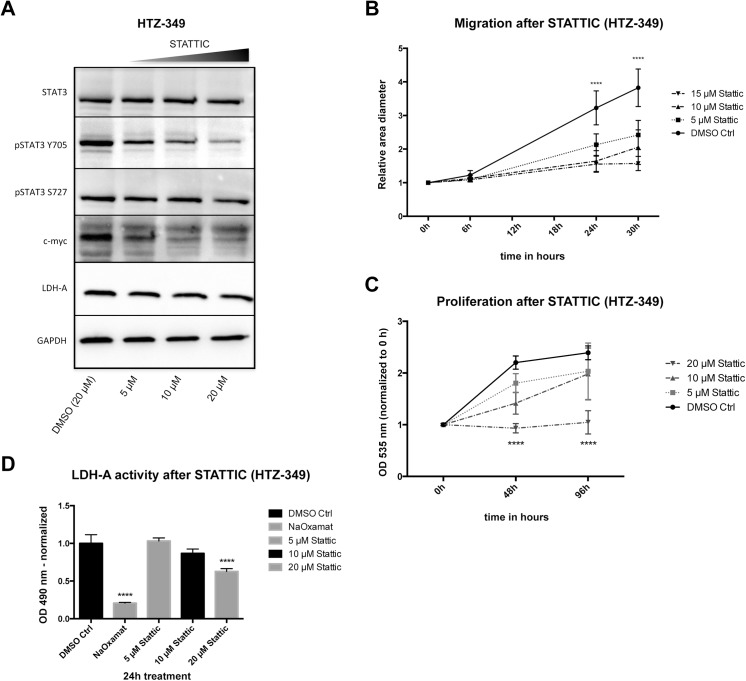
Inhibition of STAT-3 phosphorylation modulates signalling along with functional effects.STAT-3 phosphorylation at Y705 is inhibited by STATTIC. HTZ-349 cells were exposed to increasing STATTIC concentrations (5, 10, 15/20 μM) for 24 h. (A) pSTAT-3, c-myc, and LDH-A expression were investigated by Western blot (40 μg of protein). A decrease in both phosphorylation of pSTAT-3 and expression of its downstream targets, c-myc and LDH-A, was observed. Total STAT-3 and STAT-3 phosphorylated at the S727 residue remained unchanged (for quantification see S8A Fig). Migration (B) and proliferation (C) showed a significant concentration-dependent inhibition (95% CI, **** = p < 0.0001) with increasing doses of STATTIC. Migration was inhibited significantly from 24 h on with all concentrations (B), whereas proliferation was reduced significantly with 20 μM starting at 48 h (C). LDH-A activity was reduced in a concentration-dependent way, with significance when cells were exposed to 20 μM of STATTIC (D) (95% CI, **** = p < 0.0001).